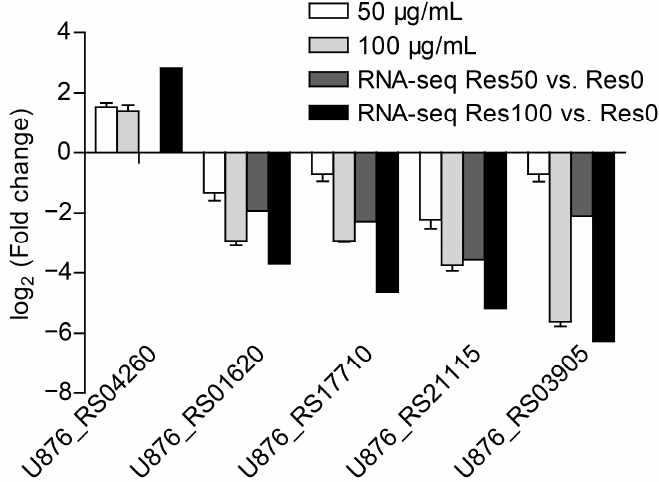
Figure 8. Validation of four different randomly selected genes by qRT-PCR.